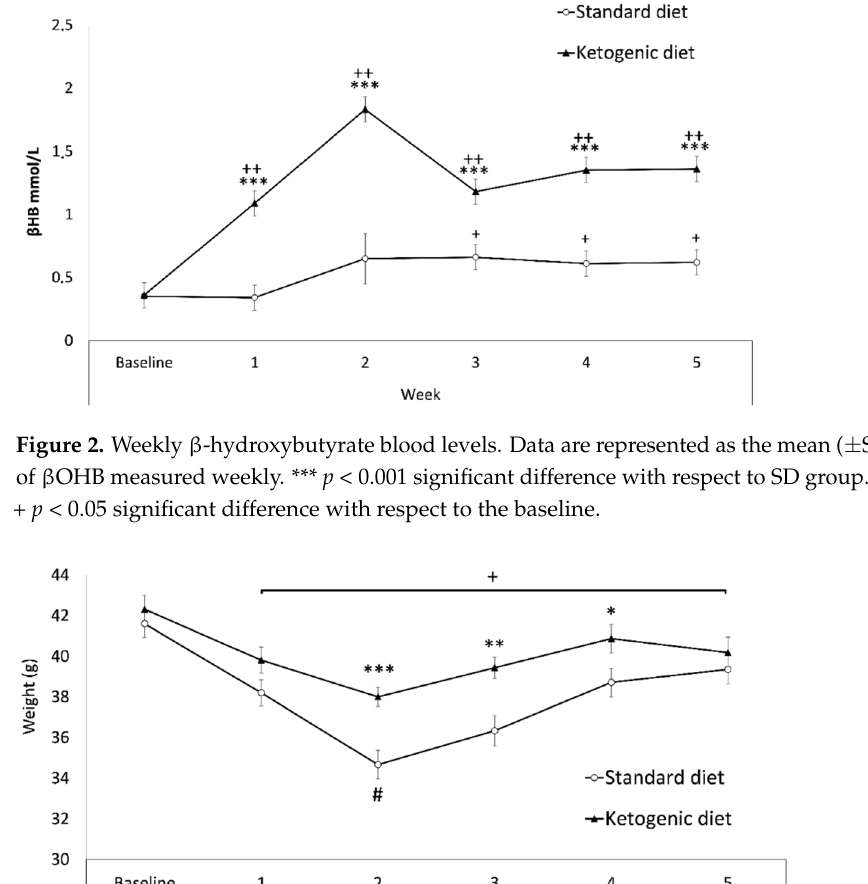
Figure 2. Weekly β-hydroxybutyrate blood levels. Data are represented as the mean (±SEM) amount of βOHB measured weekly. *** p < 0.001 significant difference with respect to SD group. ++ p < 0.001; + p < 0.05 significant difference with respect to the baseline.